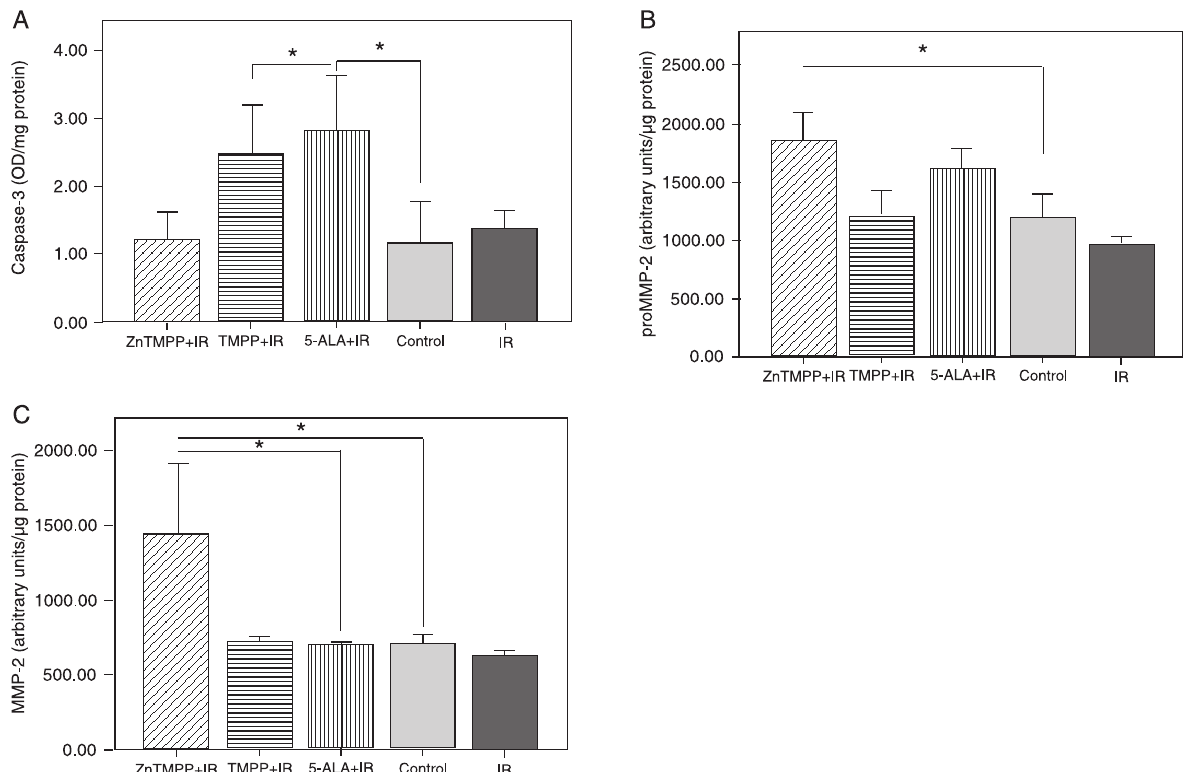
Figure 2. Activities of caspase-3 (A), proMMP-2 (B) and MMP-2 (C) in tumor tissue 24 h after photodynamic therapy with 5-ALA, TMPP and ZnTMPP. The results were compared with those of control and irradiated (IR) groups. Data are reported as means ± SD of three independent experiments. MPP-2 = metalloprotease-2; proMMP-2 = pro-metalloprotease-2; 5-ALA = 5-aminolevulinic acid; TMPP = 5,10,15,20-tetrakis(4-methoxyphenyl)-porphyrin; ZnTMPP = TMPP zinc compound. Statistical analysis was done by the Mann-Whitney U-test and the Kruskal-Wallis test. A , *P < 0.05; B , *P < 0.05; C , *P <